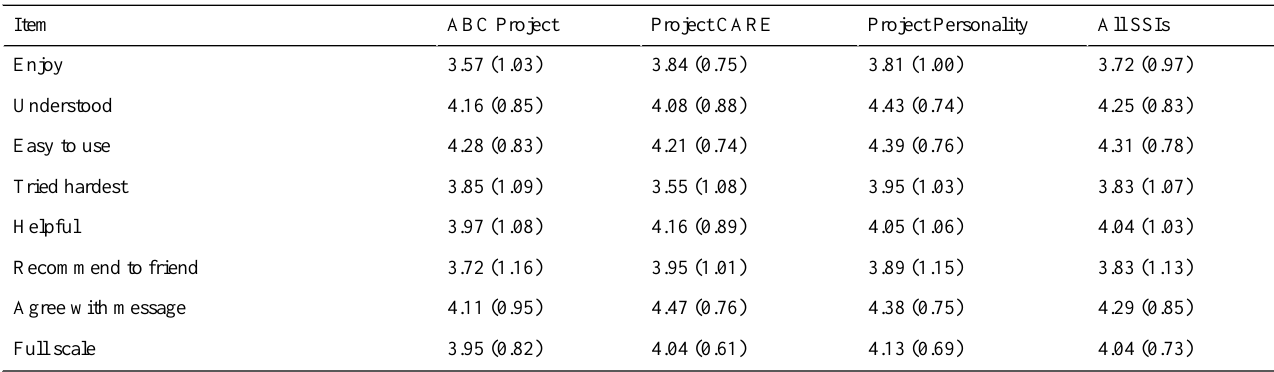
Table 3. Means and standard deviations of Program Feedback Scale items among SSI completers, by selected SSI and across all SSIs, mean (SD).